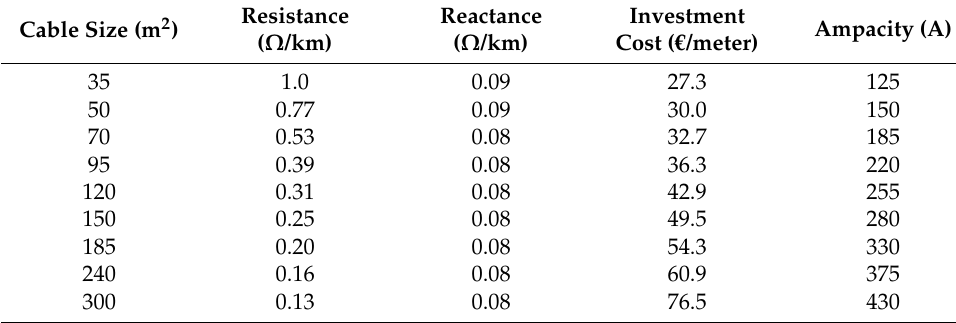
Table 2. Cable sizes and distinctive